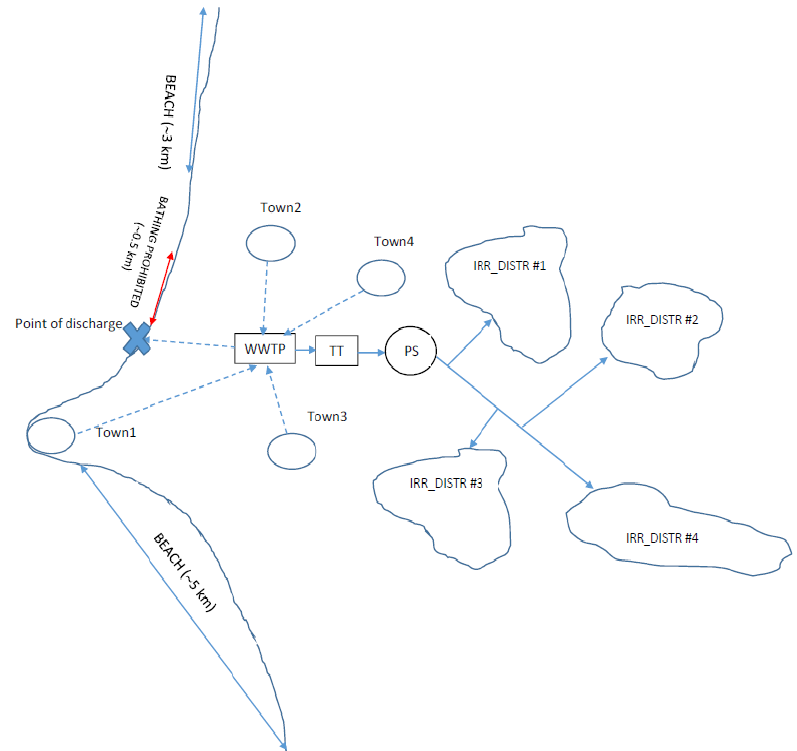
Figure 1. Schematic of the study area.